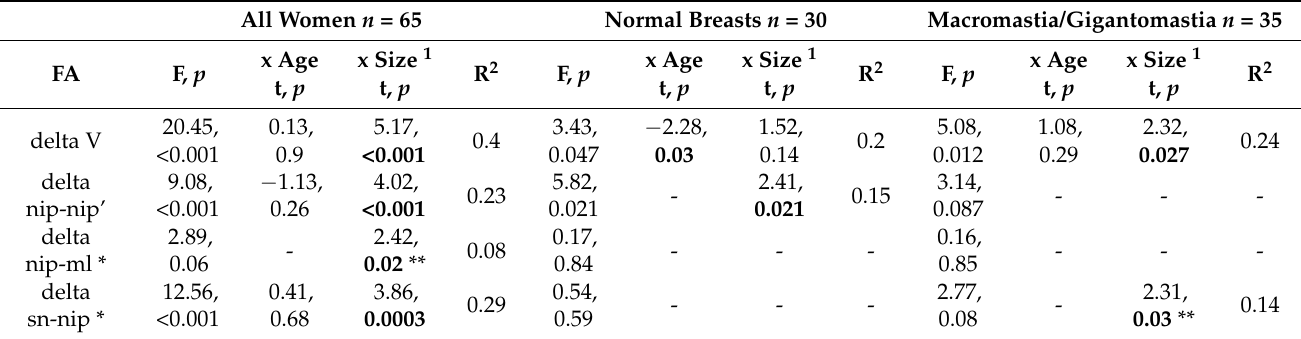
Table 2. Linear regression models and tests for age and breast size as independent variables and breast volume and nipple position FAs as dependent